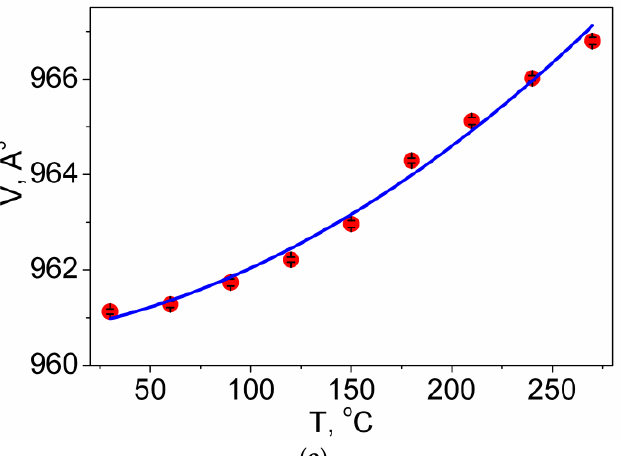
Figure 3. Thermal dependence of Pr 2 (SO 4 ) 3 cell parameters: ( a ) a (T); ( b ) b (T); ( c ) c (T); ( d ) β(T); ( e ) V (T).